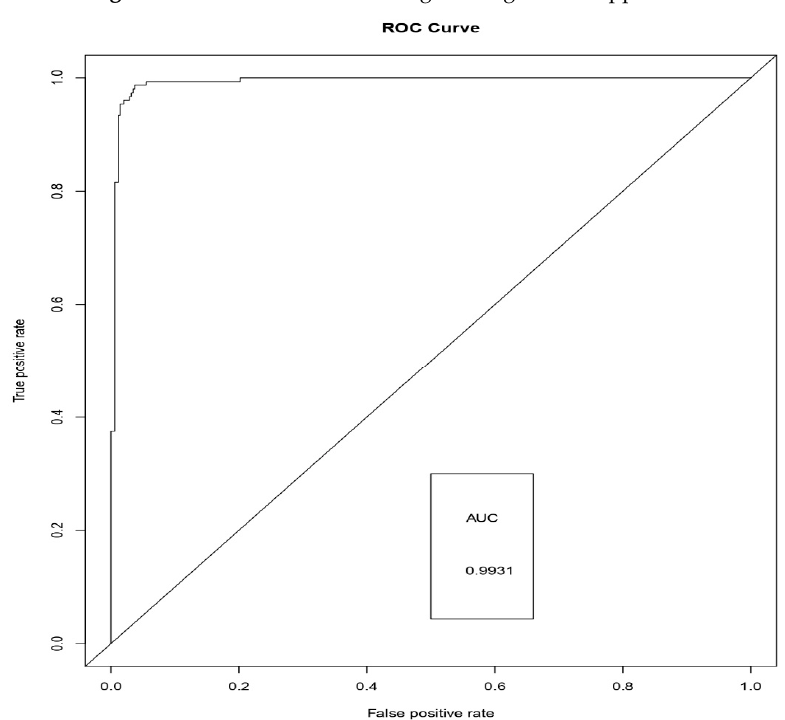
Figure 7. AUC-ROC for Random Forest Approach.